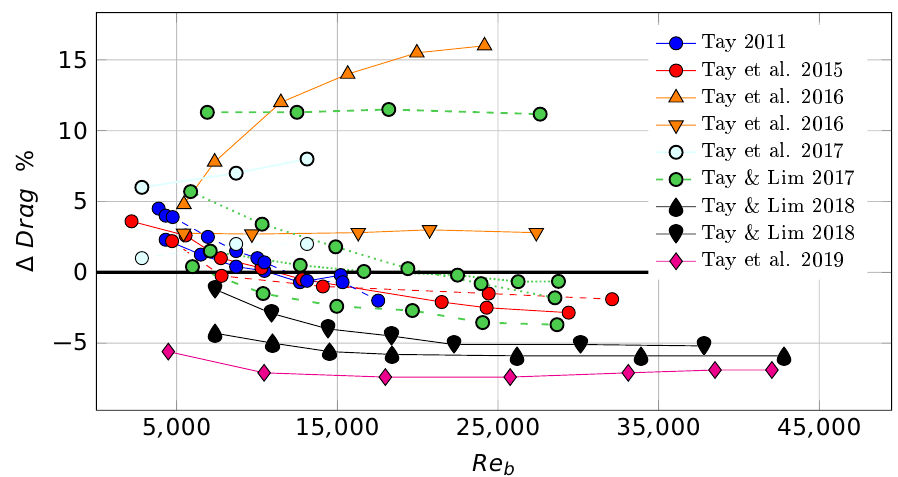
Figure 6. Drag change versus bulk Reynolds number Re b [14,17,18,20–22,27].